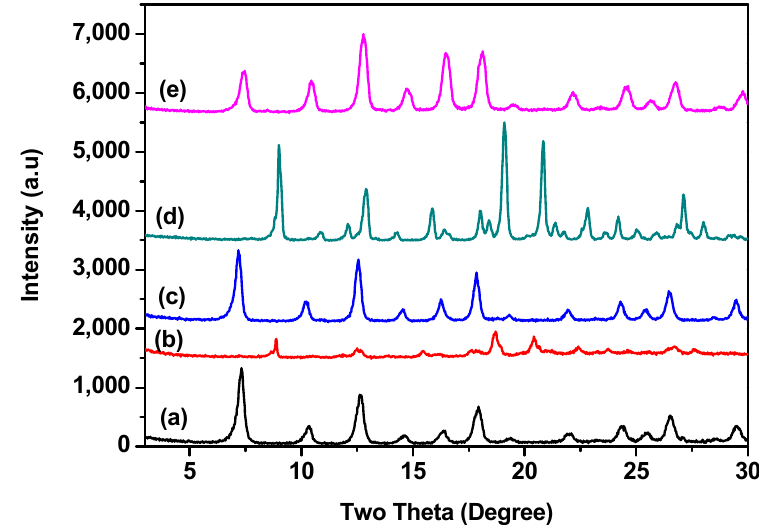
Figure 5. XRD patterns of fresh ZIF-8 (a), recovered ZIF-8 from the reaction between benzaldehyde and ethyl acetate in water at 80 °C (b), ZIF-8 treated with water at 80 °C (c), ZIF-8 treated with benzaldehyde in water at 80 °C (d), ZIF-8 treated with ethyl acetate in water at 80 °C (e).